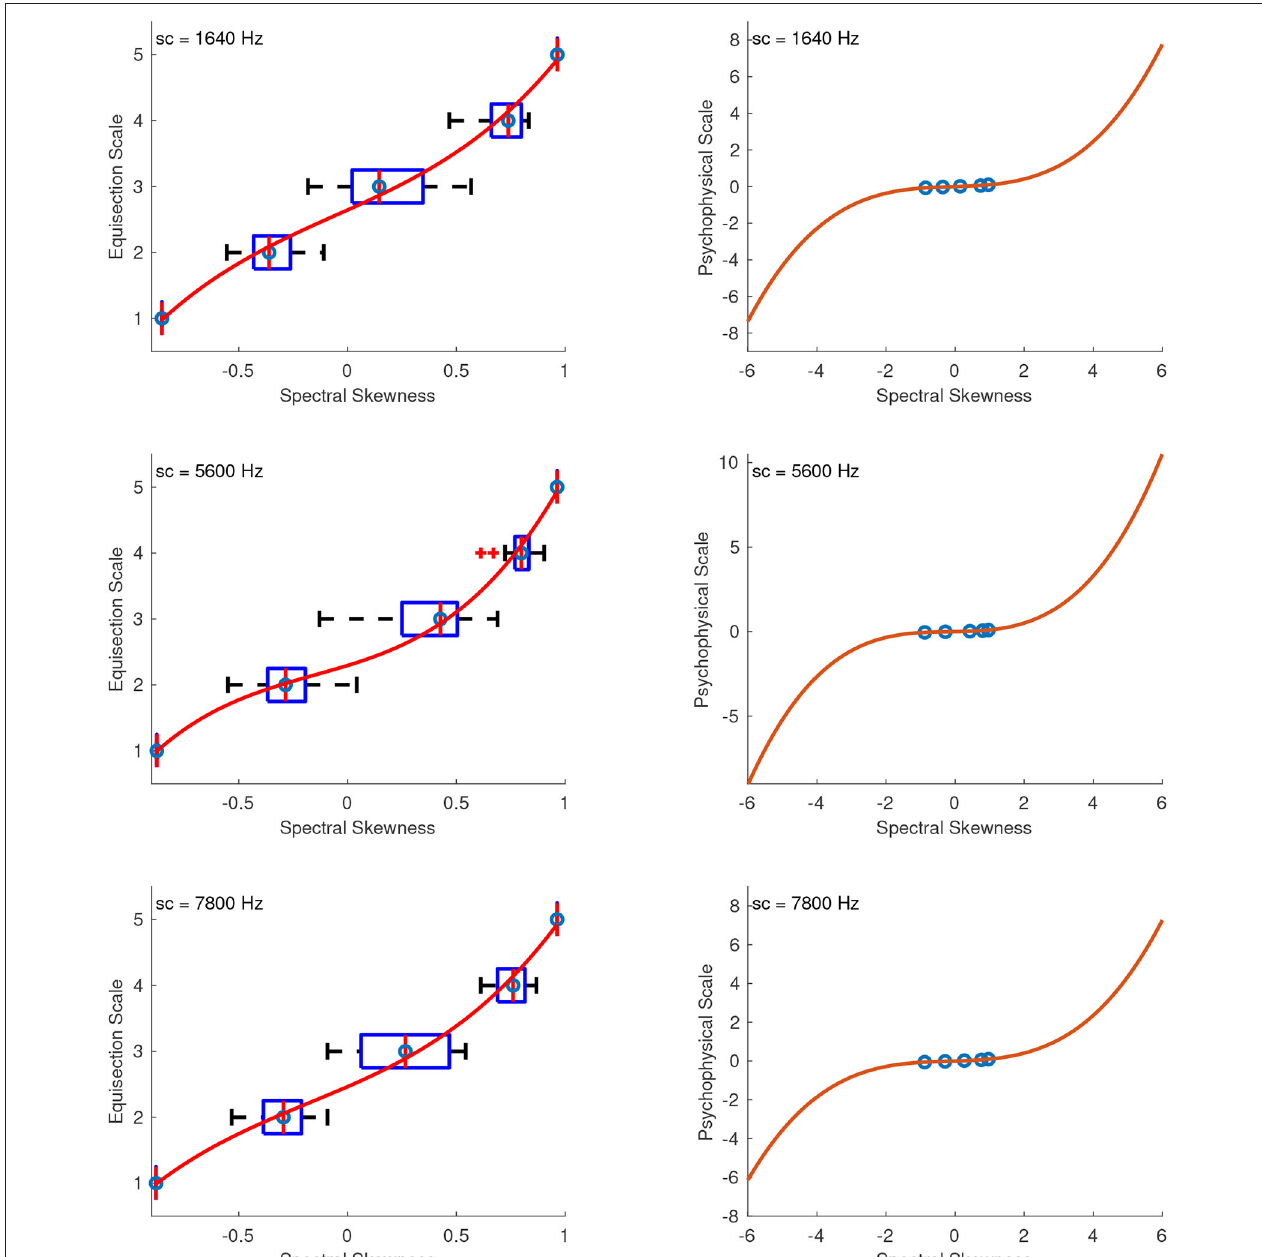
FIGURE 11 | Equisection and psychophysical scales of spectral skewness. Left panels, boxplots and fitting function on the median ratings at three values of spectral centroid (sc). Whiskers extend to 2.7 SD; Right panels, psychophysical scale and extrapolated fitting functions.